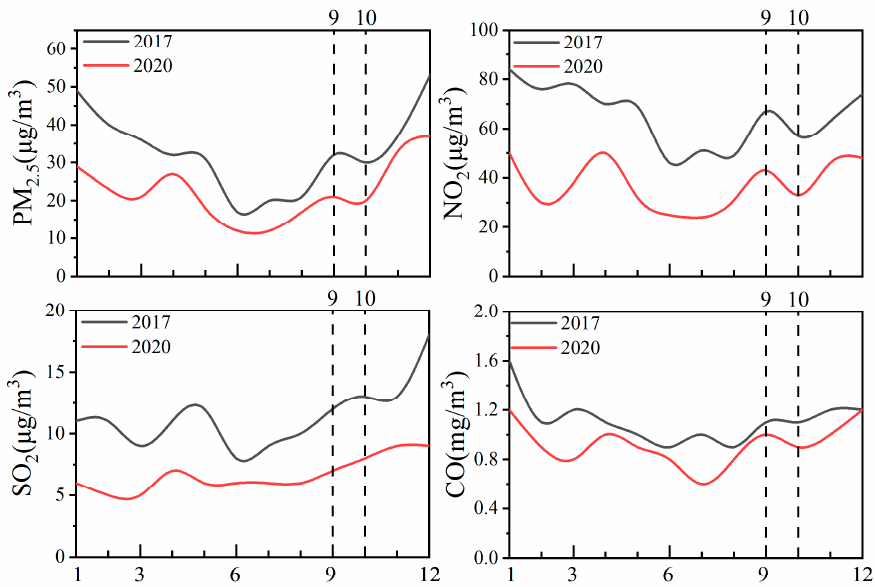
Figure 2. Monthly variation of the pollutant concentrations in Guangzhou in 2017 and 2020.